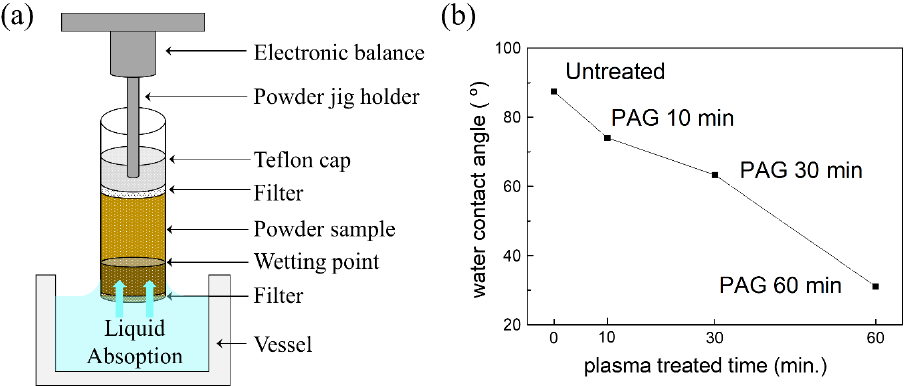
Figure 8. Measurement of the powder contact angle using the Washburn method. ( a ) Schematic of the measuring device, ( b ) water contact angle results of plasma-treated carbon powder on water.